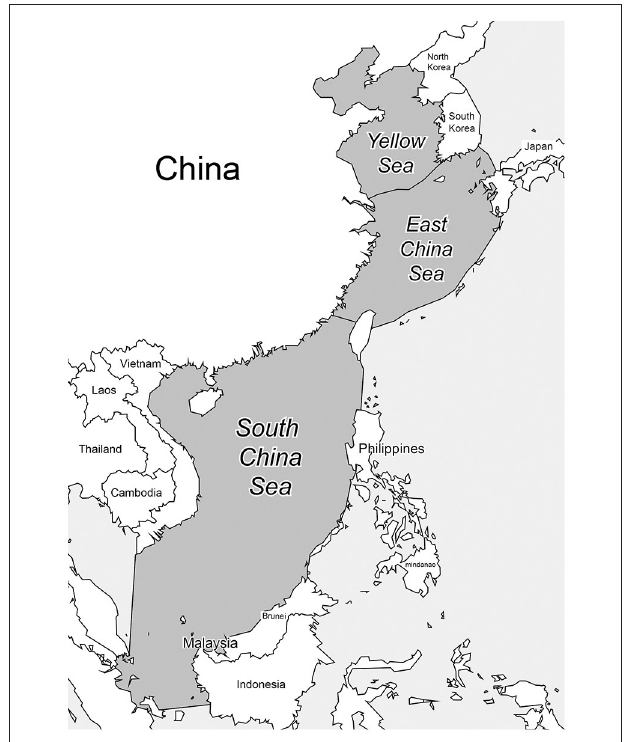
FIGURE 1 | The three Large Marine Ecosystems adjacent to the Chinese coast, i.e., the Yellow Sea, the East China Sea, and the South China Sea.